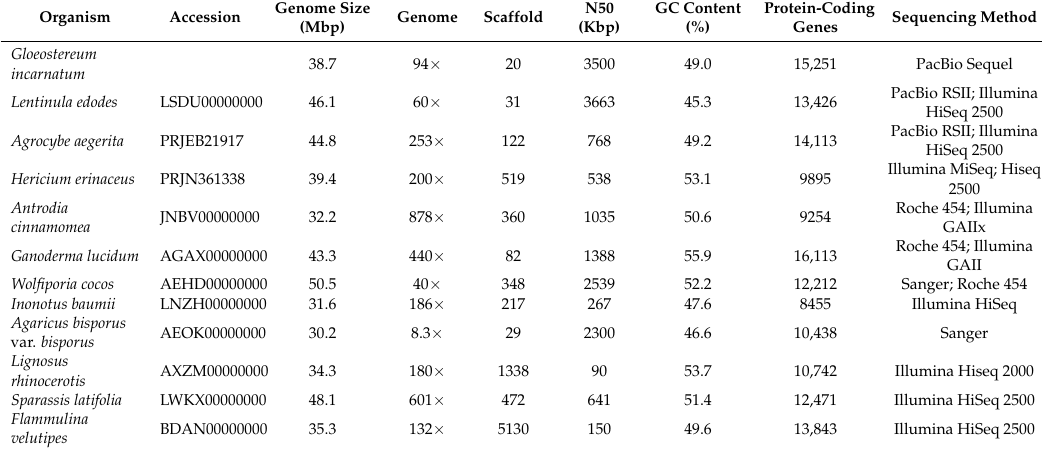
Table 1. Comparison of genome assembly among representative edible